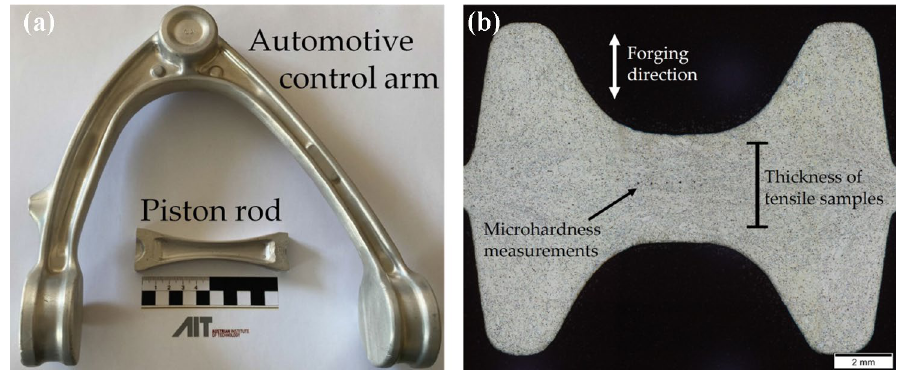
Fig. 2 Showing a Mg parts produced in laboratory (piston rod) and industrial sized forg- ing (automotive control arm), b cross section of a piston rod (in T6-temper) and measurement